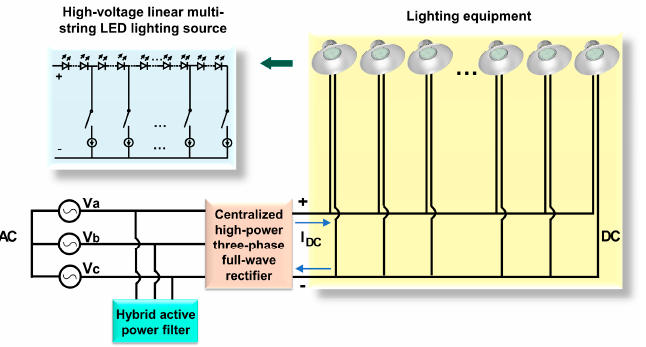
Figure 10. Schematic diagram of centralized high-power three-phase power supply system for lighting equipment.